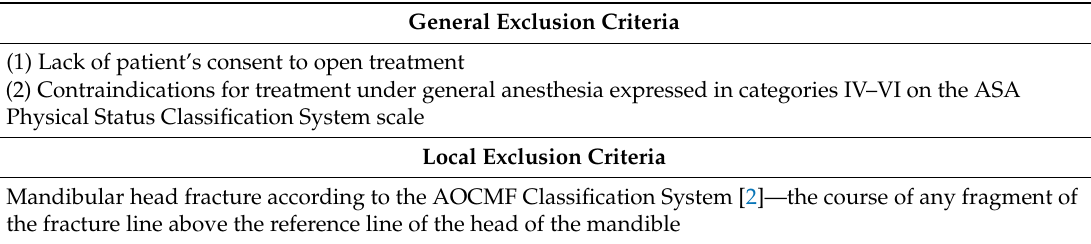
Table 2. Criteria for excluding patients from the study.